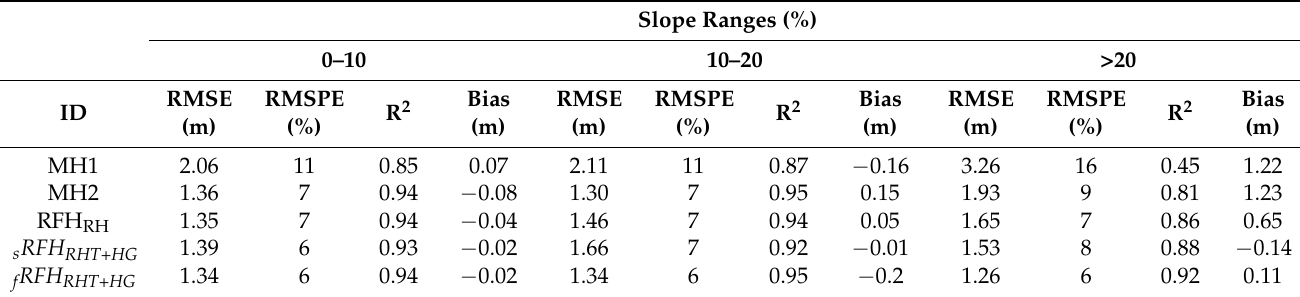
An analysis of the slope effects on the accuracy of H dom is presented in Figure 8, which shows the variability of the difference between the estimated and in situ H dom . The results shown in Figure 8 indicate that the slope effect on H dom estimates using the models (MH2) and (RFH RH ) were not completely eliminated for slopes higher than 15%. Indeed, for both models, the median difference between estimated and in situ H dom increased from − 0.08 and − 0.06 for, respectively, the models (MH2) and ( RFH RH ) for slope ranges ]10–15%] to 1.2 and 0.59 m for slope ranges higher than 20% (between 20 and 45%). In contrast, the slope effects on H dom estimates using the Wang-based methodology ( s RFH RHT+HG , or f RFH RHT+HG ) was greatly reduced, and the median difference between estimated and in situ H dom ranged between − 0.096 and 0.0.12 m for ( s RFH RHT+HG ) and between − 0.25 and 0.17 m for ( f RFH RHT+HG ).